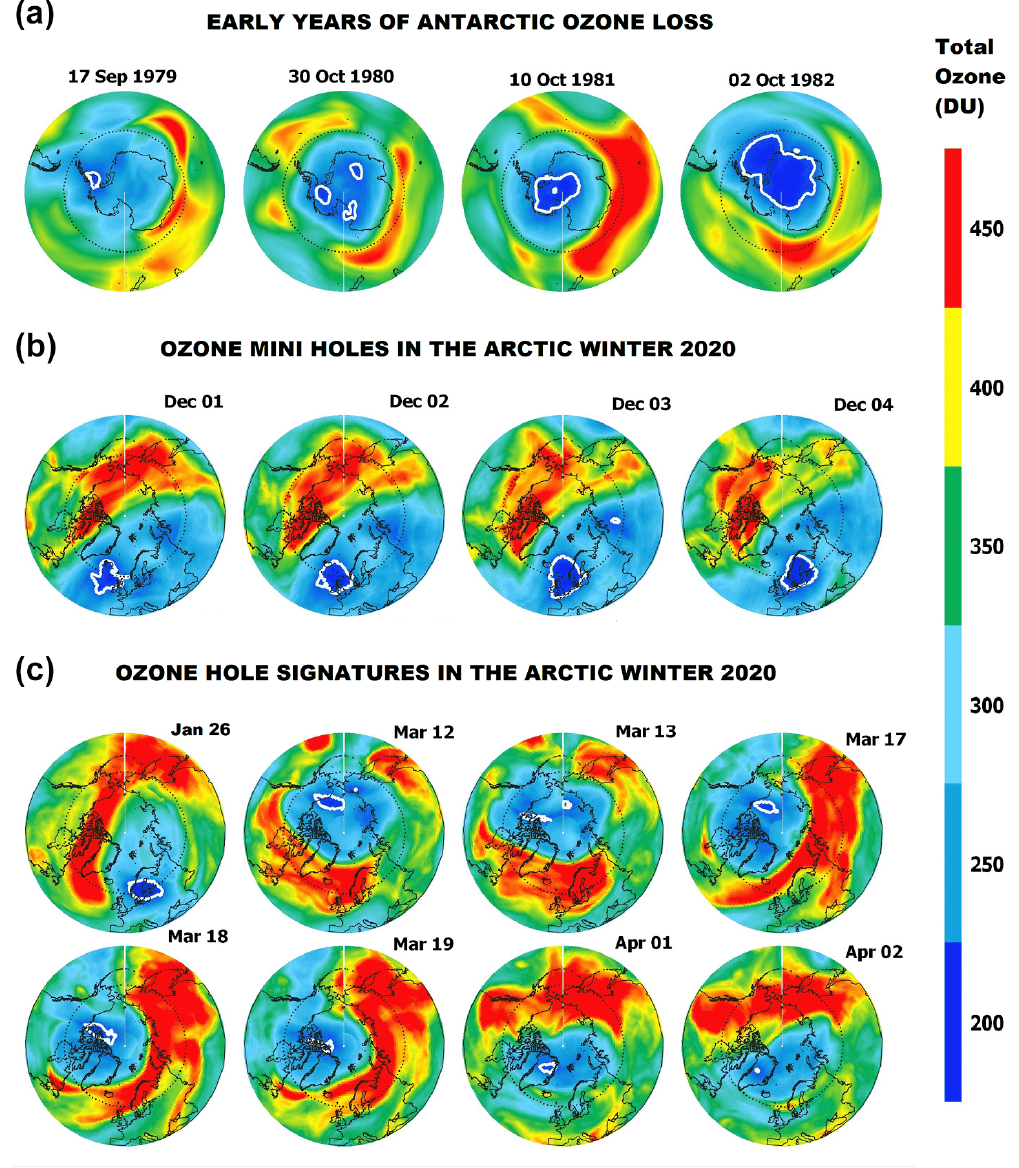
Figure 8. Maps of total column ozone from MERRA-2 and OMPS satellite measurements for selected days. The Antarctic ozone hole is defined as the area below 220DU of ozone, as demarcated by the white contour. The top panel (a) shows the early years of the Antarctic ozone hole, the middle panel (b) shows the ozone mini-holes driven by dynamics, and the bottom panel (c) shows the ozone column observed in the Arctic winter of